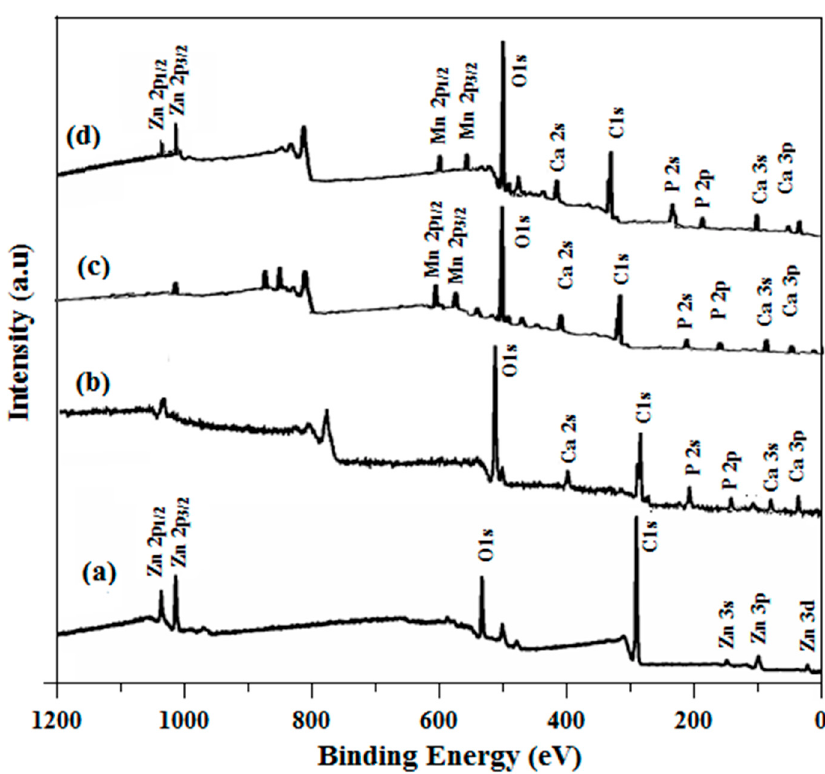
Figure 5. XPS analysis of ( a ) ZnO, ( b ) HAp, ( c ) Mn-HAp, and ( d ) Mn-HAp/ZnO bilayer coating on 316L SS.